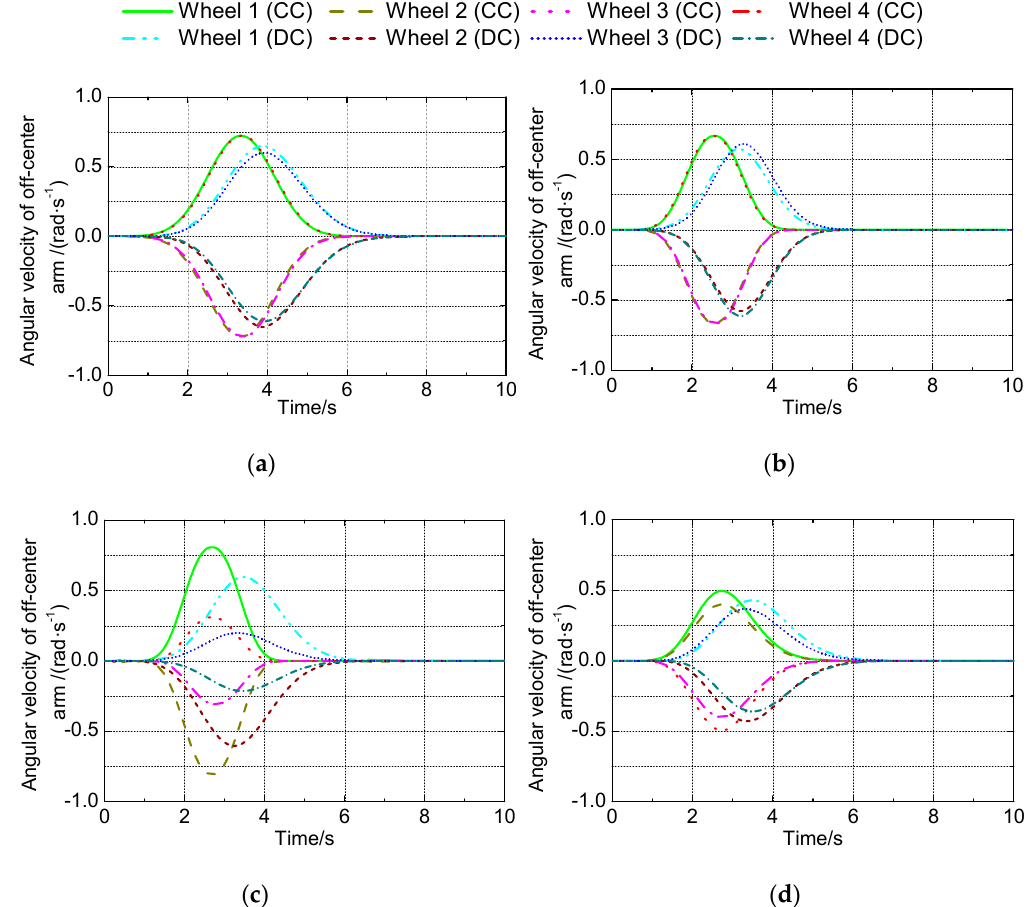
Figure 10. Angular velocity curves of the four off-center arms during motion mode switching: ( a ) cross motion; ( b ) in-place rotation; ( c ) diagonal motion; ( d ) steering motion.